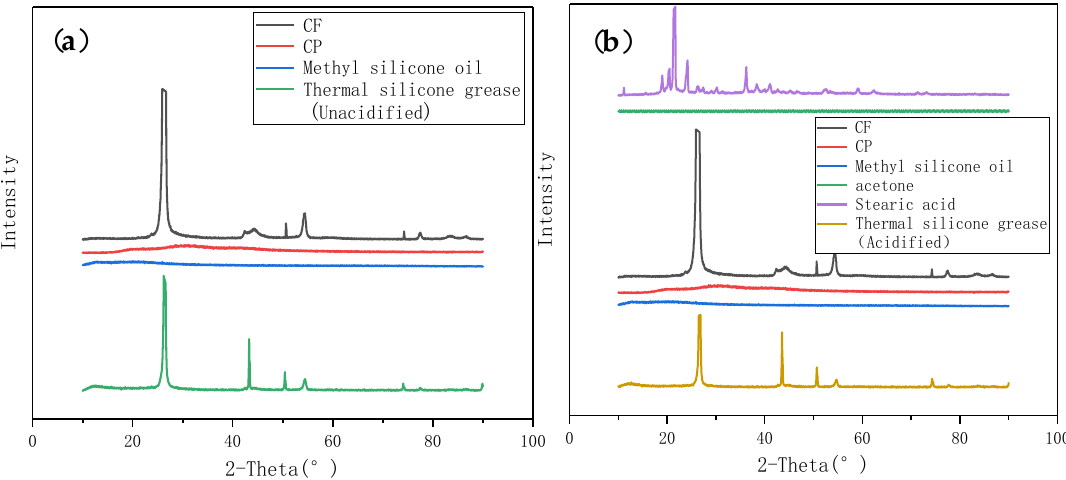
Figure 10. XRD pattern. ( a ) XRD characteristic peak of unacidified TSG and its components. ( b ) XRD characteristic peak of acidified TSG and its components.